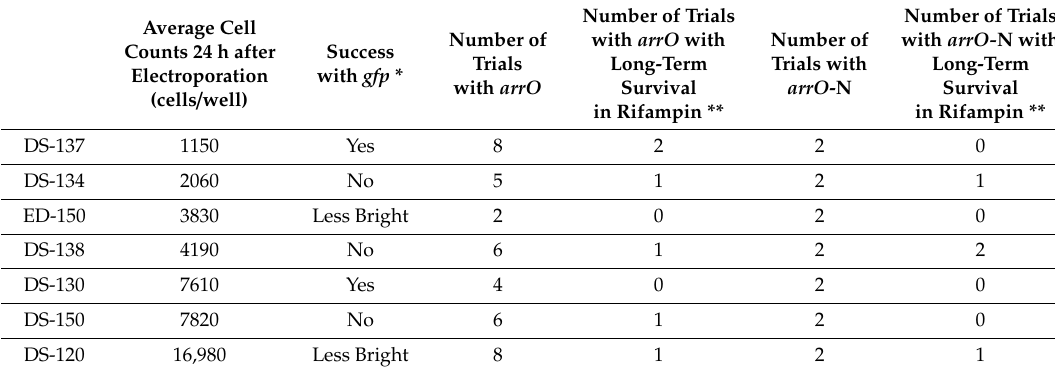
Table 3. Adequate pulse code settings for transformation of DinoIII- gfp , DinoIII- arrO , and DinoIII- arrO -N into Oxyrrhis